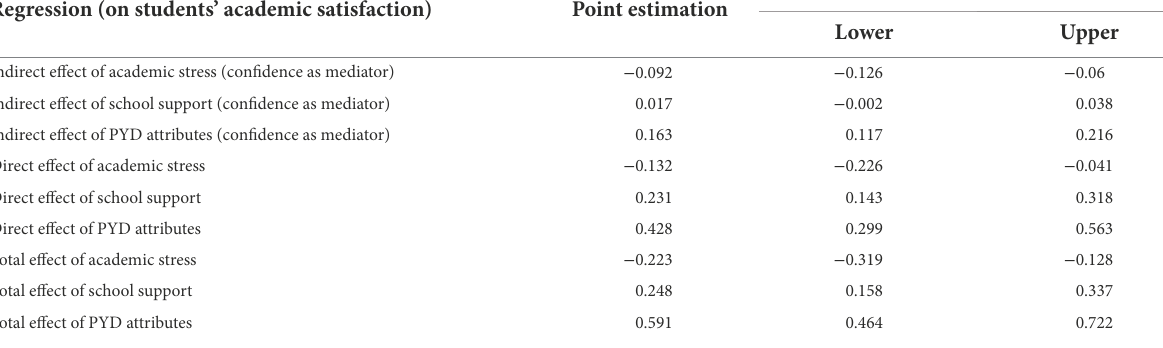
Regression (on students’ academic satisfaction) Point